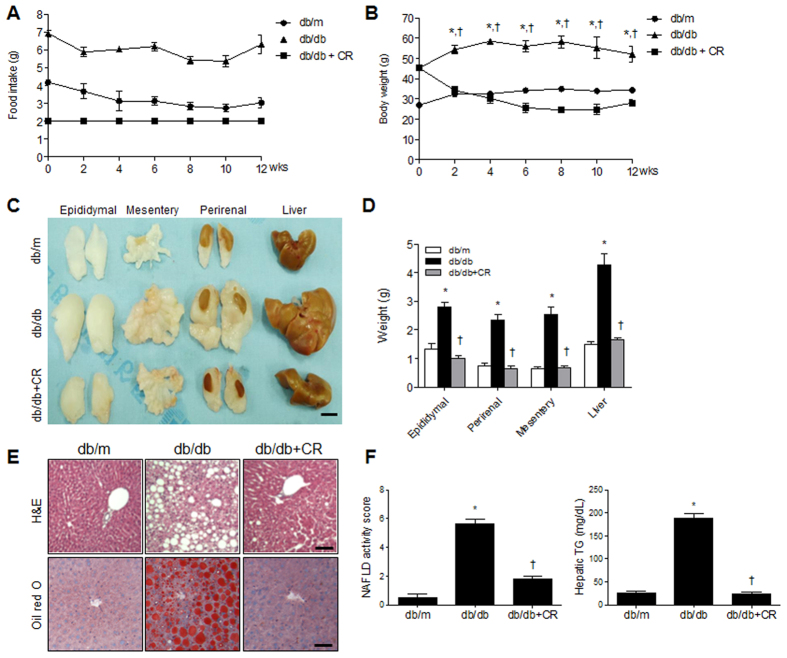
Effects of caloric restriction (CR) on obesity and hepatic steatosis in db/db mice.Food intake (A) and body weight (B) of db/db and db/m mice. Gross morphology (C) and weight (D) of intraabdominal fat deposits (epididymal fat pads, mesentery fat, and perirenal fat) and the liver. (E) Histological analysis of hepatic fat accumulation by H&E and Oil red O staining. Scale bar, 100 μm. (F) NAFLD activity score and concentration of hepatic triglycerides (TGs). Data are shown as the mean ± SEM. *p < 0.05 for db/db versus db/m mice. †p < 0.05 for db/db+CR versus db/db mice.